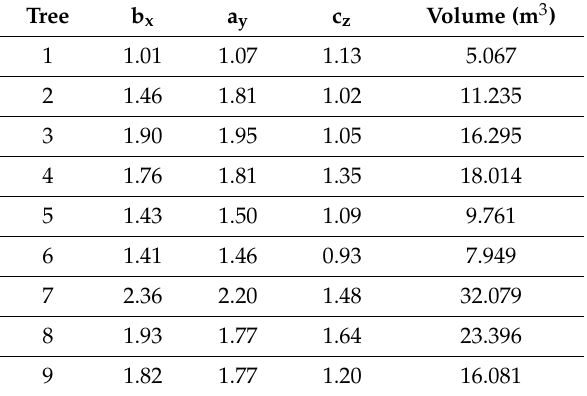
Table 1. Traditional method (TM) results. a y , b x , c z are the semi-axes of the ellipsoid, Equation (1).